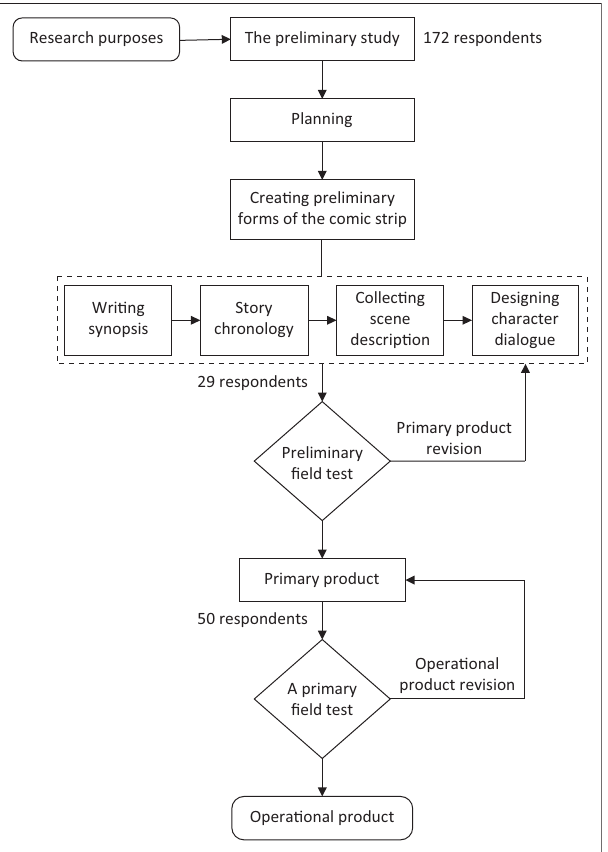
FIGURE 2 : Diagram of the development process in creating comic